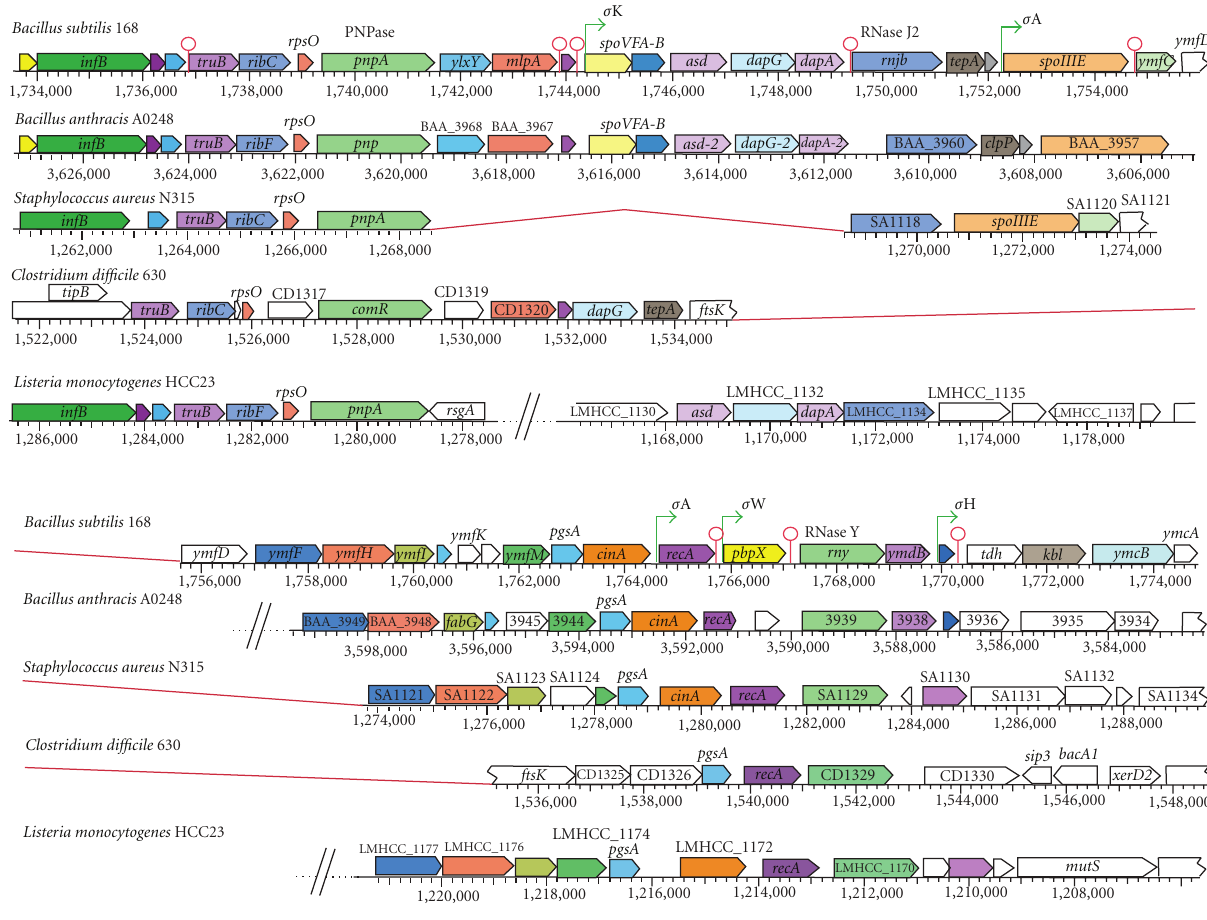
Figure 3: Alignment of the genomic context for three components of the RNA degradosome. Homologues of PNPase, RNase J2, and RNase Y were aligned from the di ff erent Gram-positive organisms, Bacillus subtilis 168, Bacillus anthracis A0248, Staphylococcus aureus N315, Clostridium di ffi cile 630, and Listeria monocytogenes HCC23. Alignments were made using the multigenome alignment tool on http://www.biocyc.org/. Red lines indicate directly adjacent regions of the chromosome and the diagonal lines indicate a chromosomal gap. Genes that are conserved in bacteria are shown with the same